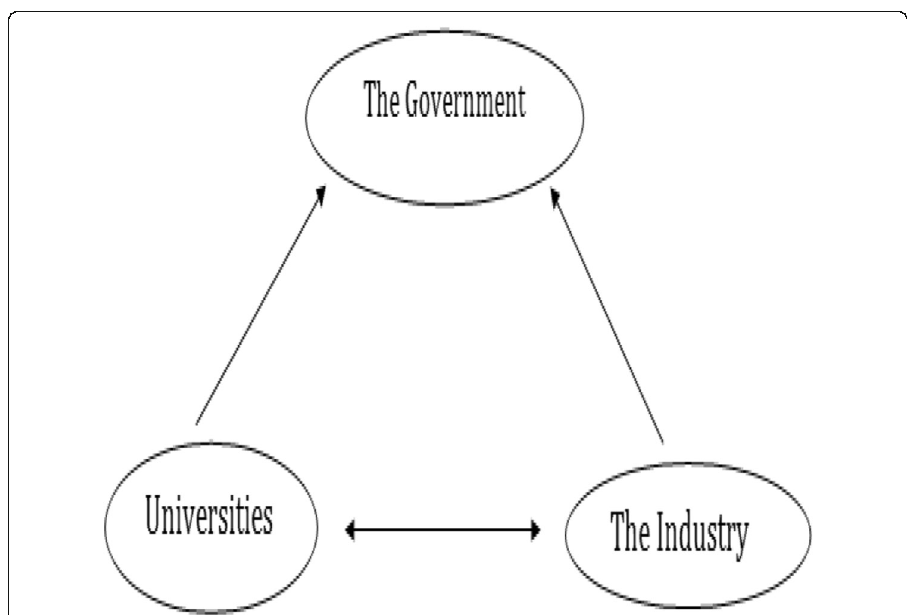
Fig. 1 The triple helix of innovation in